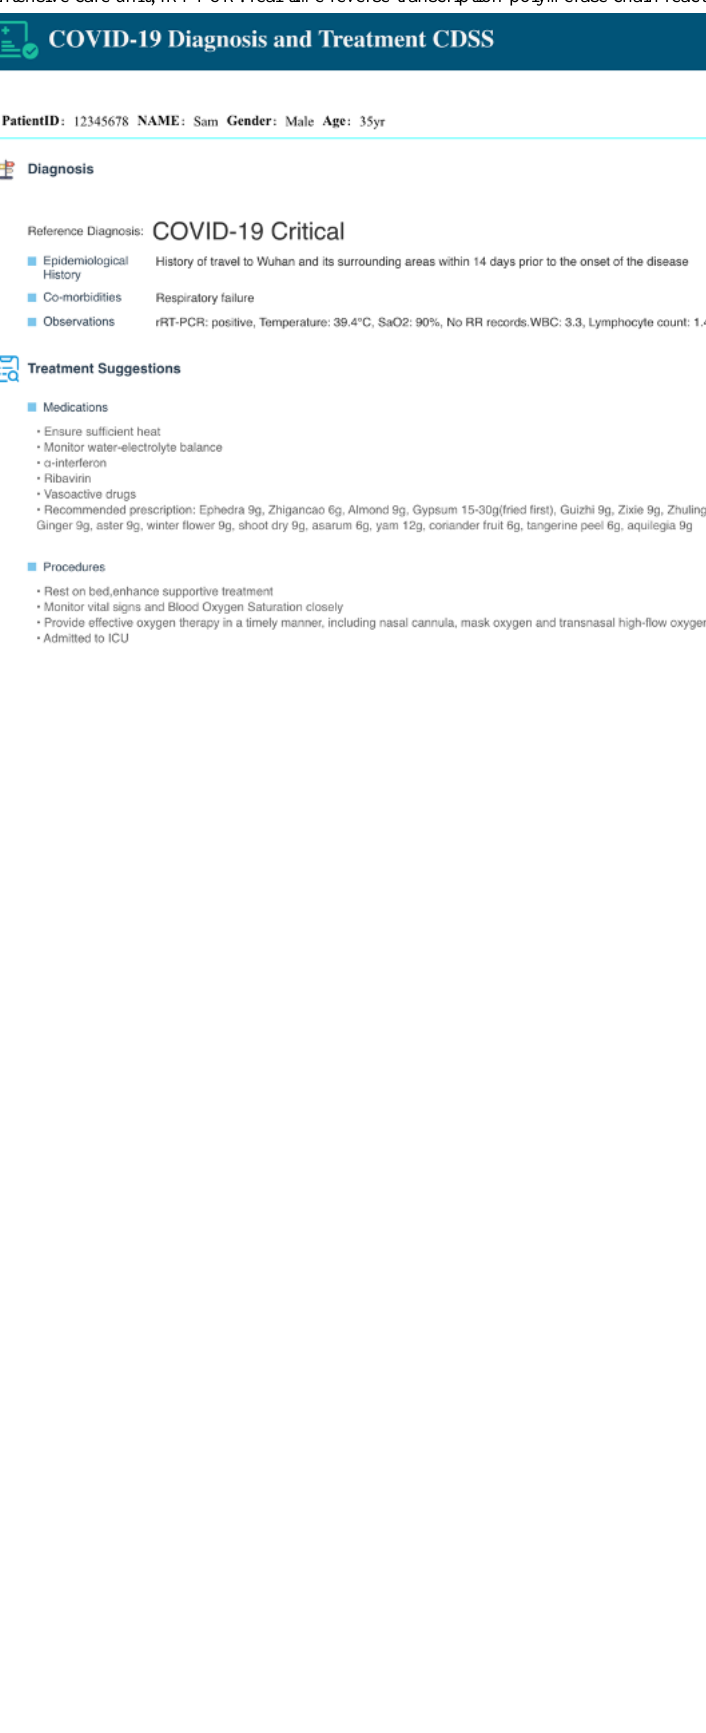
Figure 5. The data view of COVID-19 Diagnosis and Treatment CDSS. CDSS: clinical decision support system; COVID-19: coronavirus disease; ICU: intensive care unit; rRT-PCR: real time reverse transcription-polymerase chain reaction; WBC: white blood